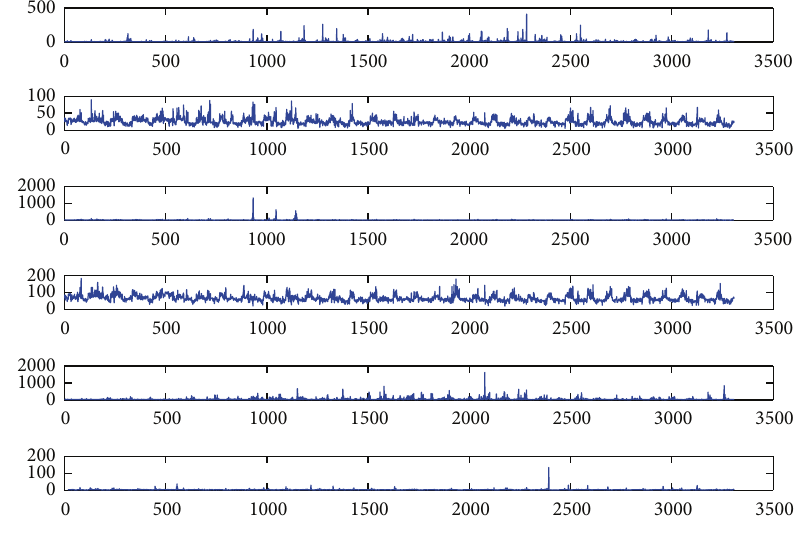
Figure 4: Oscillogram of the raw data.